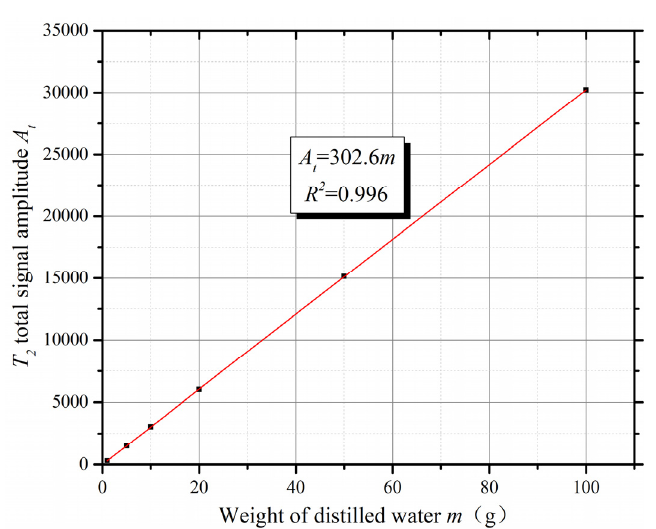
Figure 3. The relationship between the T 2 total signal amplitude and weight of distilled water. The line is the fitting line of the points. The Equation in the box is the Equation of the line. R 2 indicates the correlation coefficient of the Equation.